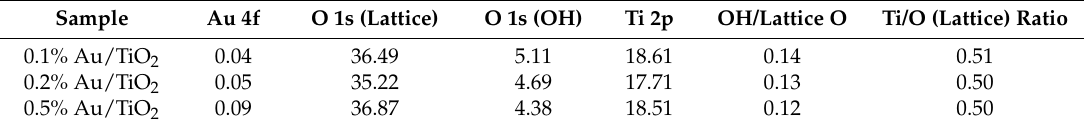
Table 3. XPS Analysis of the surface composition of fresh